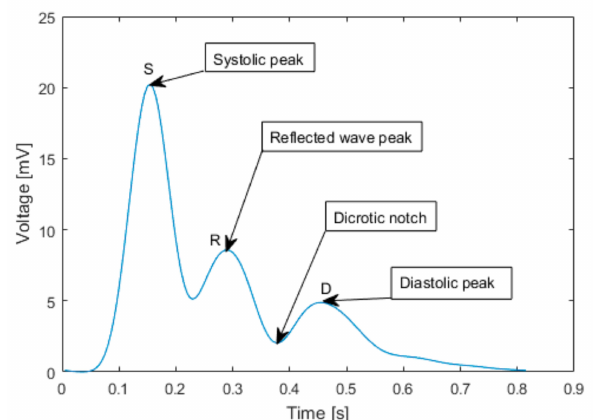
Figure 2. The typical pulse wave acquired from the left brachial artery by the arm cu ff inflated to suprasystolic pressure. Systolic peak (S) corresponds to contraction of the left ventricle, Reflected wave peak (R) corresponds to reflected wave from iliac bifurcation and Diastolic peak (D) corresponds to the delayed reflected wave from the lower